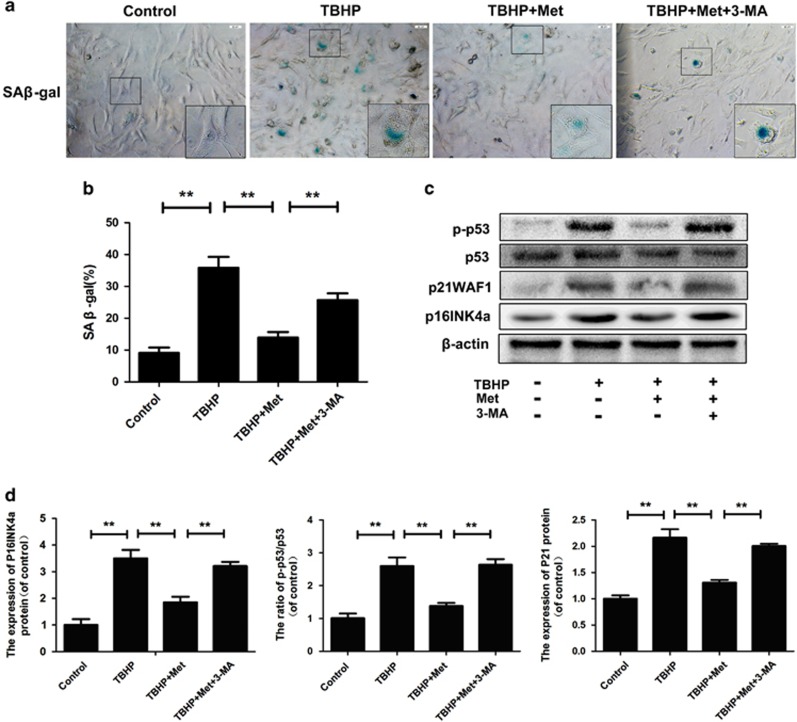
Metformin treatment alleviates nucleus pulposus cells senescence under oxidative stress. (a–b) SA-β-gal staining assay was performed in nucleus pulposus cells as treated above (original magnification × 200, scale bar: 20 μm). (c–d) The protein expression of p-p53, P53, p21WAF1 and p16INKa in nucleus pulposus cells treated as above. The data in the figures represent the averages±S.D. Significant differences between the treatment and control groups are indicated as **P<0.01, *P<0.05, n=3